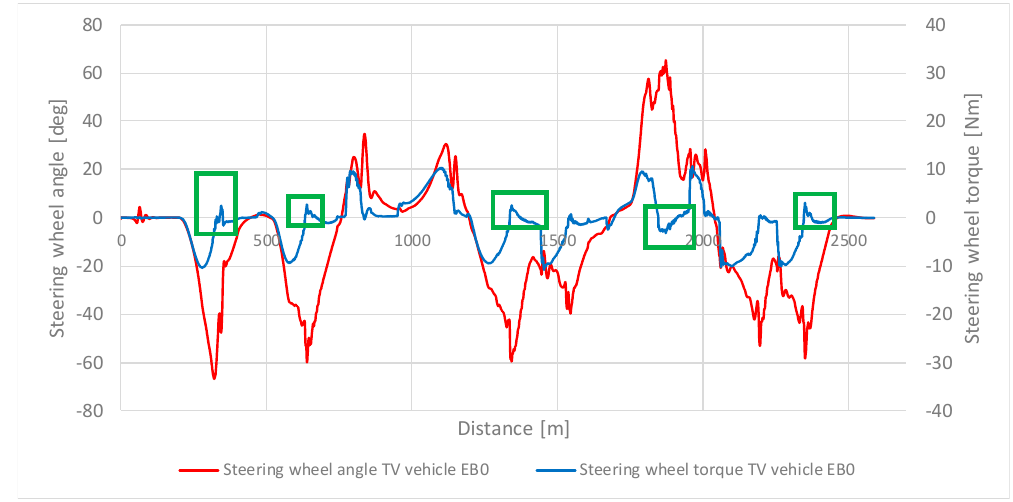
Figure 24. The TV vehicle with EB0 suspension: steering wheel angle (red) and steering wheel torque (blue). Self-steering moment showed in green boxes.